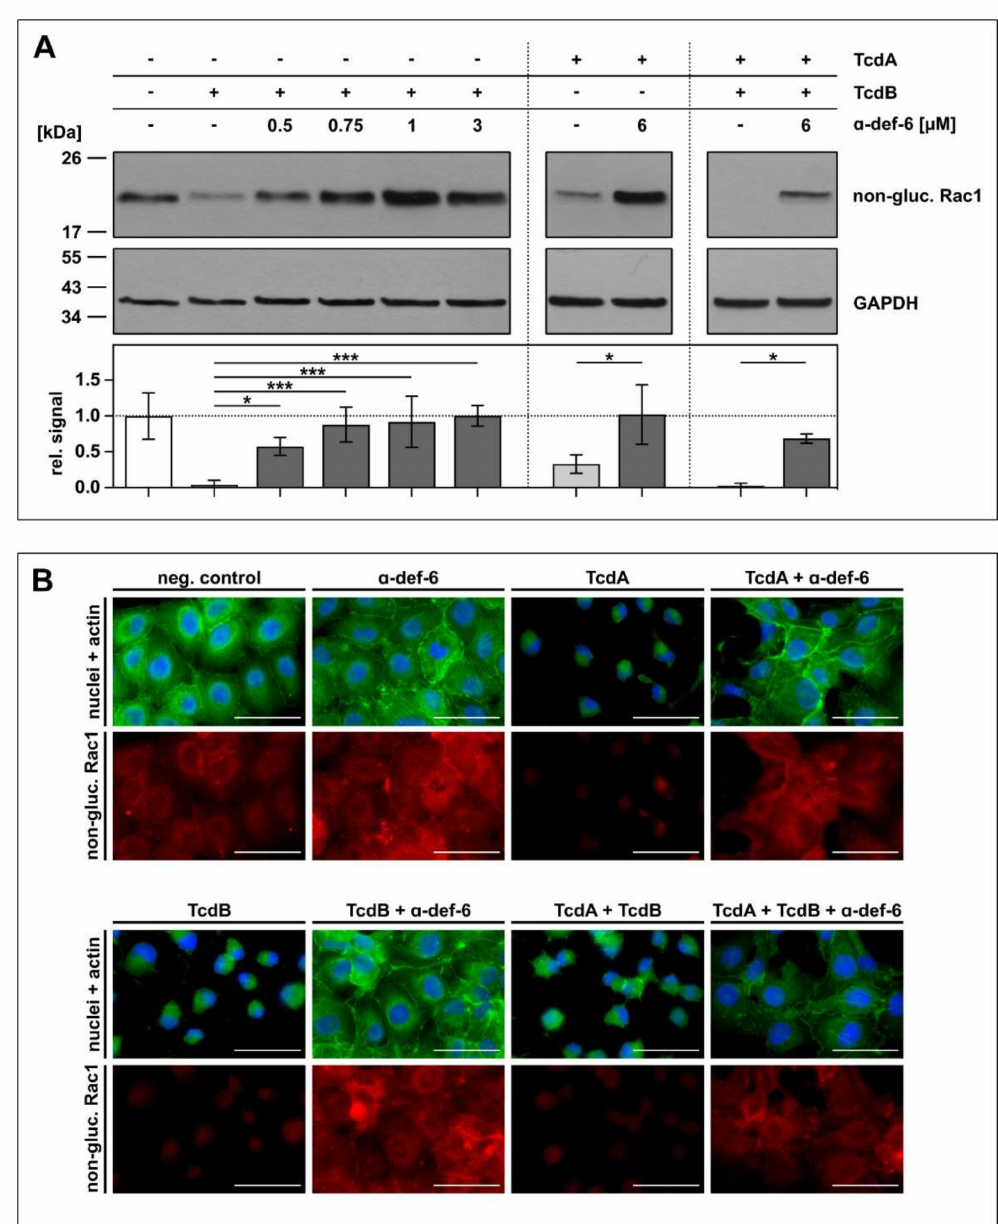
Figure 4. α -def-6 inhibits intracellular Rac1 glucosylation by TcdA, TcdB and the combination of both toxins. ( A ) Vero cells were treated with TcdA (20 pM), TcdB (10 pM) or the combination of both toxins with or without the addition of α -def-6 (concentrations as indicated) for 5 h (TcdB) or 4 h (TcdA and TcdA + TcdB), respectively. Then, the cells were harvested, lysed and subjected to SDS-PAGE followed by Western blotting. Non-glucosylated Rac1 was detected and signals were normalized to GAPDH as loading control. Representative Western blots are depicted. Relative signal intensities are given as mean ± SD of at least three biological replicates ( n ≥ 3). Significance was tested with one-way ANOVA combined with Dunnett’s multiple comparison test (* p < 0.05, *** p < 0.001). ( B ) Vero cells were treated as in ( A ). α -def-6 (6 µ M) was used alone for control. After 4 h, cells were fixed and permeabilized. Non-glucosylated Rac1 (red) was stained with an anti-Rac1-antibody in combination with a secondary Alexa Fluor 633 -conjugated antibody. Actin (green) was stained with phalloidin-FITC and nuclei (blue) via Hoechst33342. Representative images are shown ( n = 2). Scale bars correspond to 50 µ